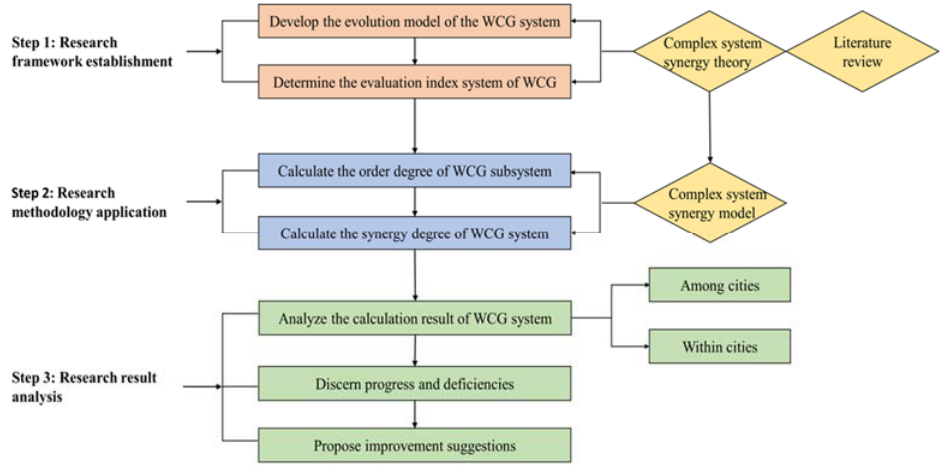
Figure 2. The procedures of the proposed methodology.